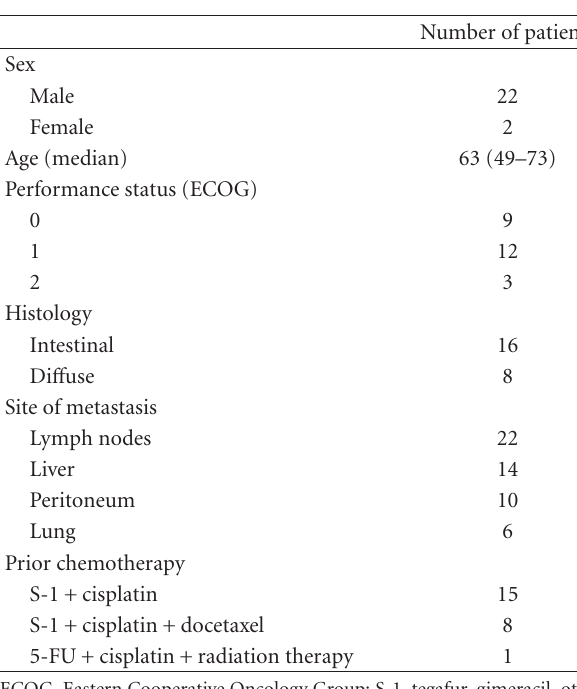
Table 1: Patient characteristics.